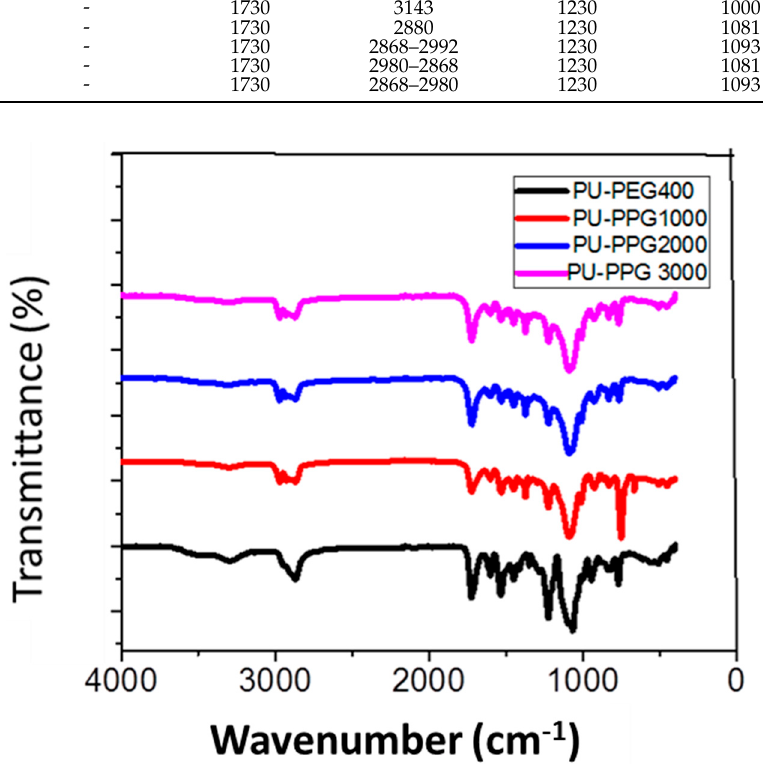
Figure 4. FTIR spectra of different polyurethanes formed from blocked isocyanates.